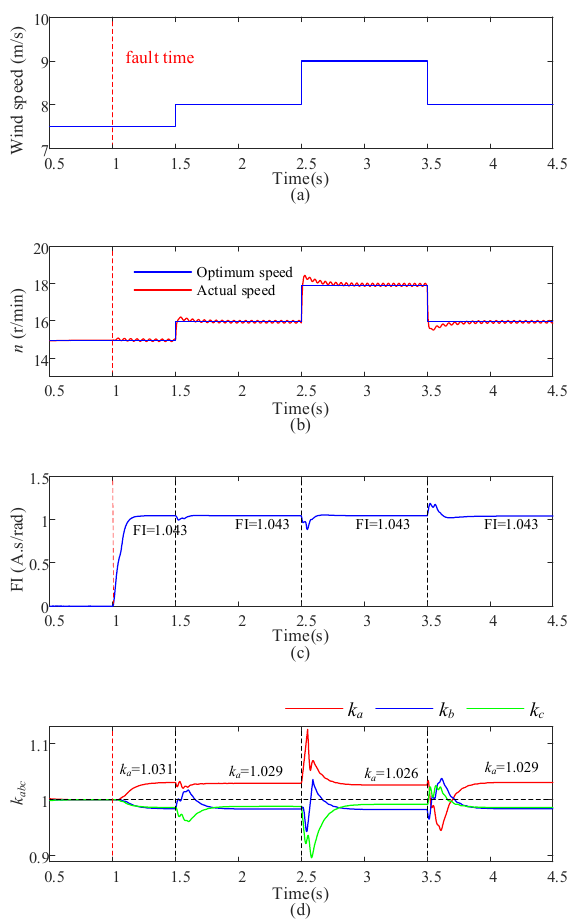
Figure 11. Fault detection results under stepped wind speed. ( a ) Stepped wind speed; ( b ) pptimum and actual speeds of PMSG; ( c ) fault detection index; ( d ) fault phase location indexes.